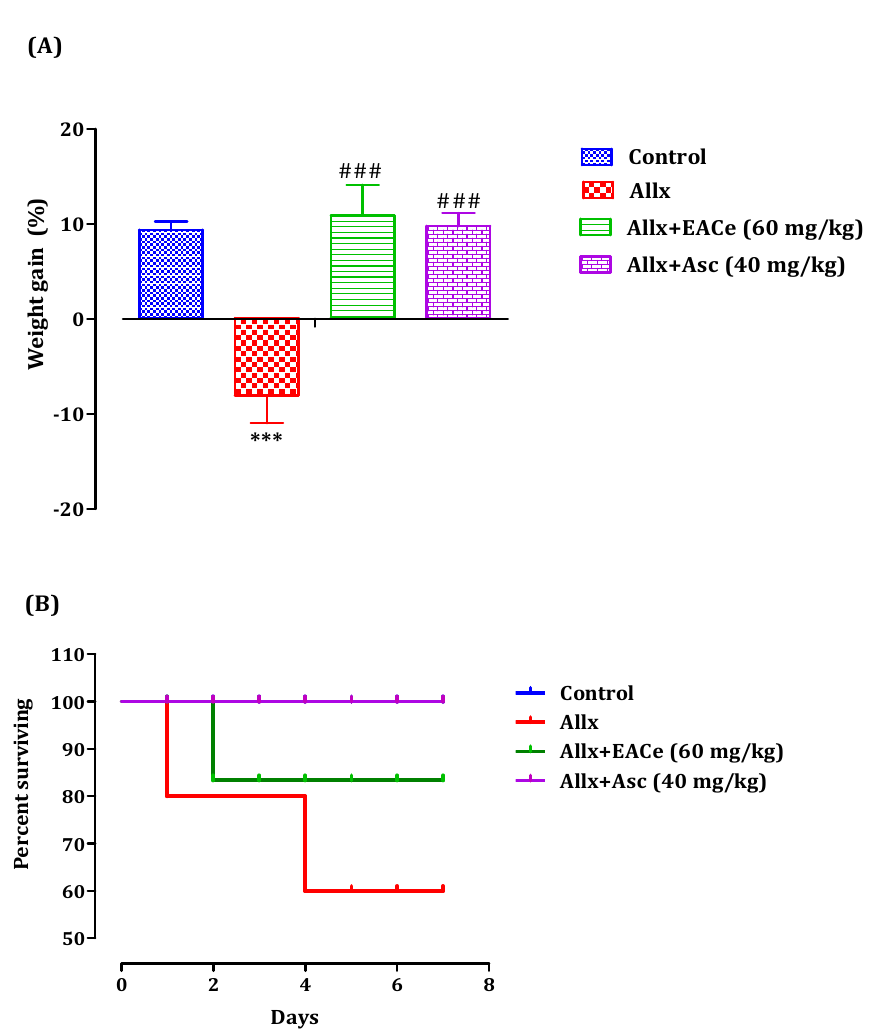
Figure 8. Effect of EACe on body weight ( A ), and survival rate of Swiss albino mice after alloxan administration ( B ). Data are means ± SEM, ( n = 7). *** p < 0.001 compared to normal control group, ### p < 0.001 compared to alloxan group. EACe: Ethyl acetate fraction of C. europaea .